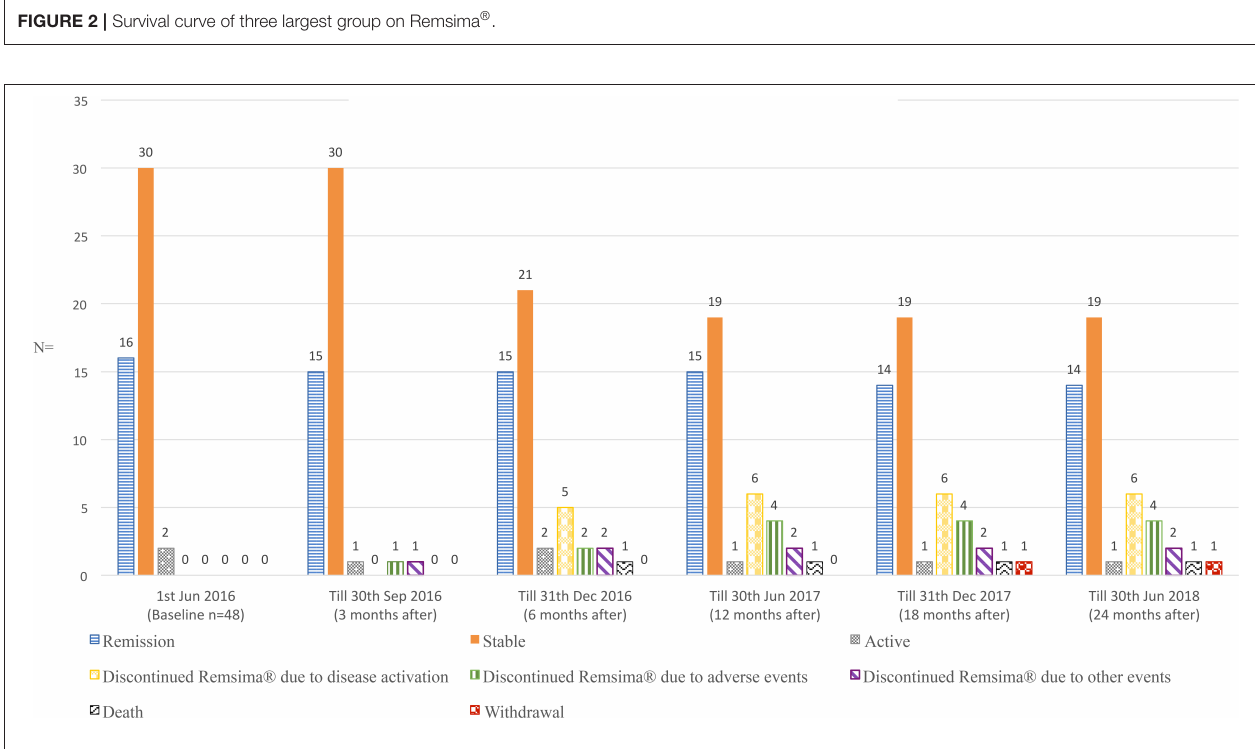
FIGURE 3 | Physicians perception of disease activity on Remsima ®